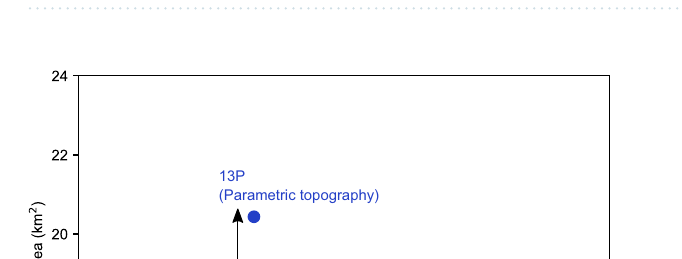
Table 2. Comparison of observed and simulated flood extents.